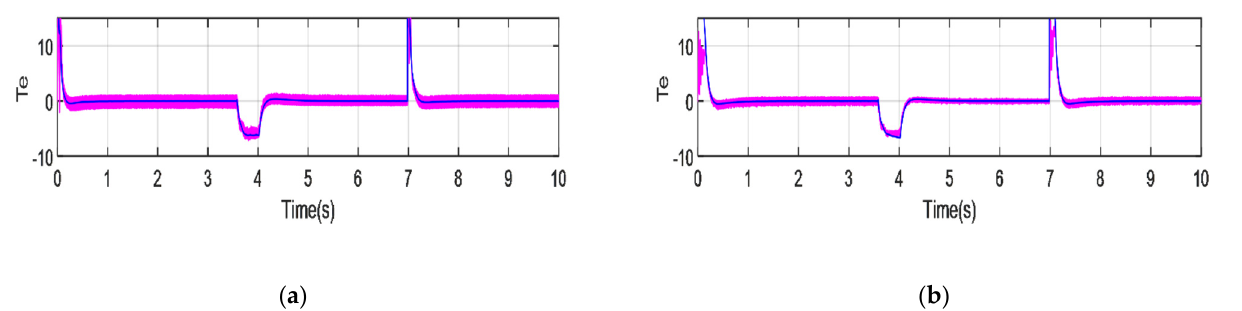
Figure 20. Torque response: ( a ) conventional inverter; ( b ) five-level inverter.